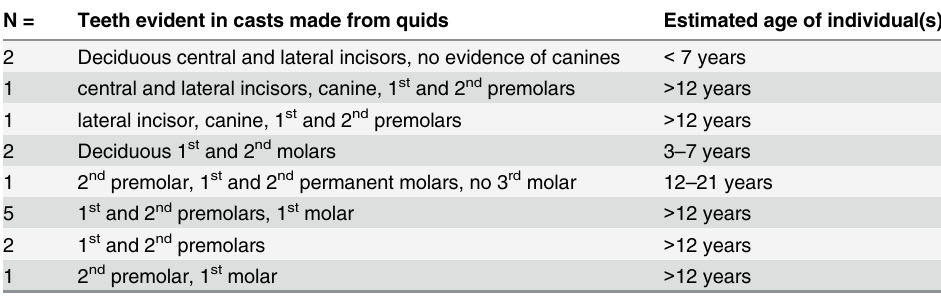
Table 1. Summary of observations for 15 apparent subadult individuals. Identification of subadult denti- tions was made on the relative size of the dental arcade, retention of deciduous teeth, and/or evidence of unerupted